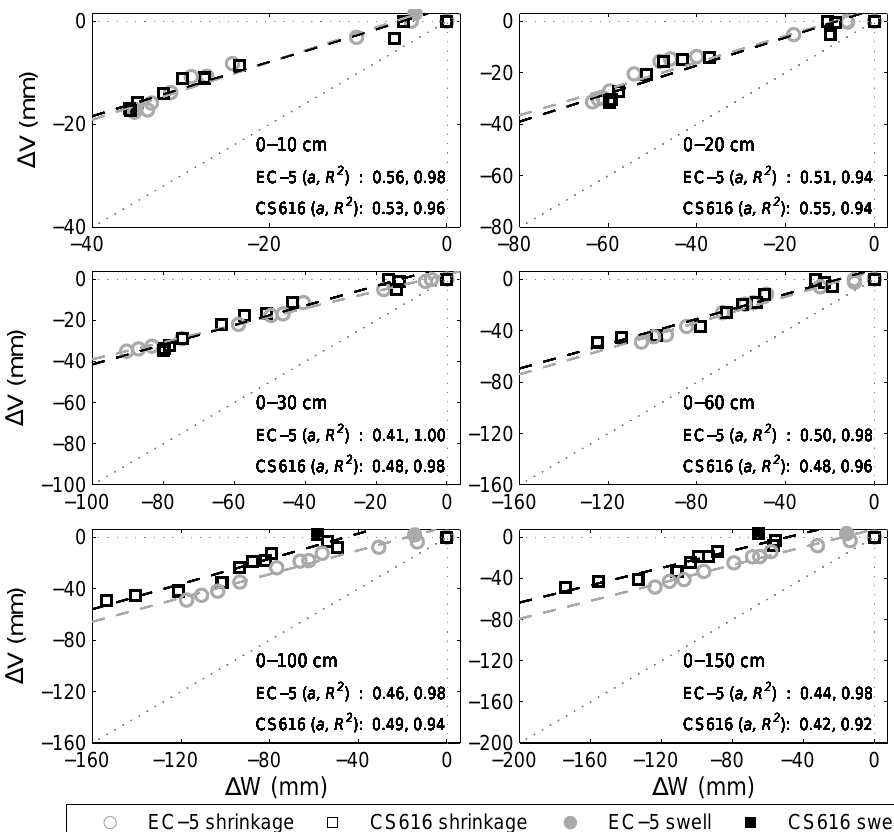
Fig. 7. As Fig. 5, but with 1V calculated using fitted r s factors and Eq. (8). Slope a and goodness of fit R 2 per layer are indicated.